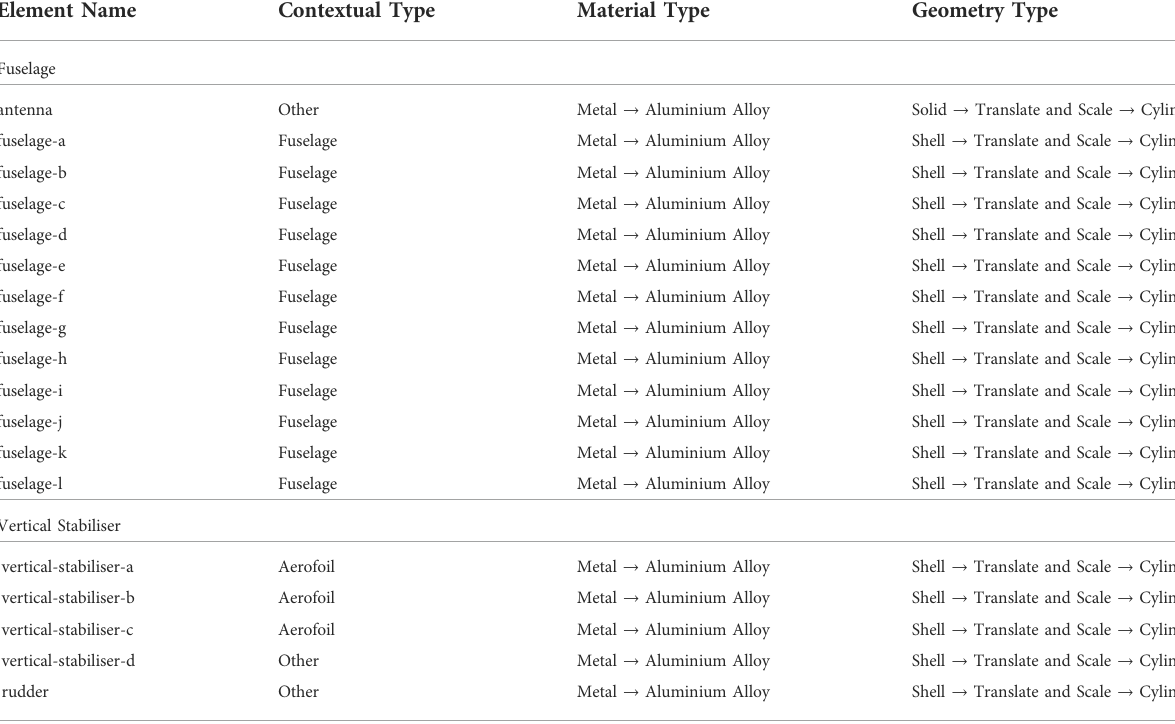
TABLE 1 Regular Elements for the Fuselage and Vertical Stabiliser of the generalised Hawk T. Mk1. As mentioned in the text, arrows point from less speci fi c to more speci fi c descriptors. For example, aluminium alloy is more speci fi c than metal . The term “ translate and scale ” refers to a type of element which does not change the shape of its cross section along a length dimension, but the shape may grow or shrink (scale). A circular cone would of this type, and a circular cylinder would be speci fi c type of